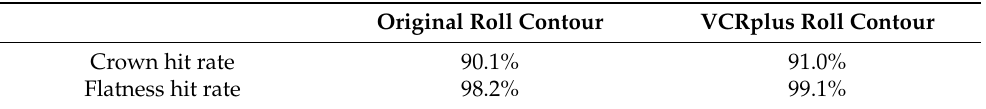
Table 9. Index of the strip